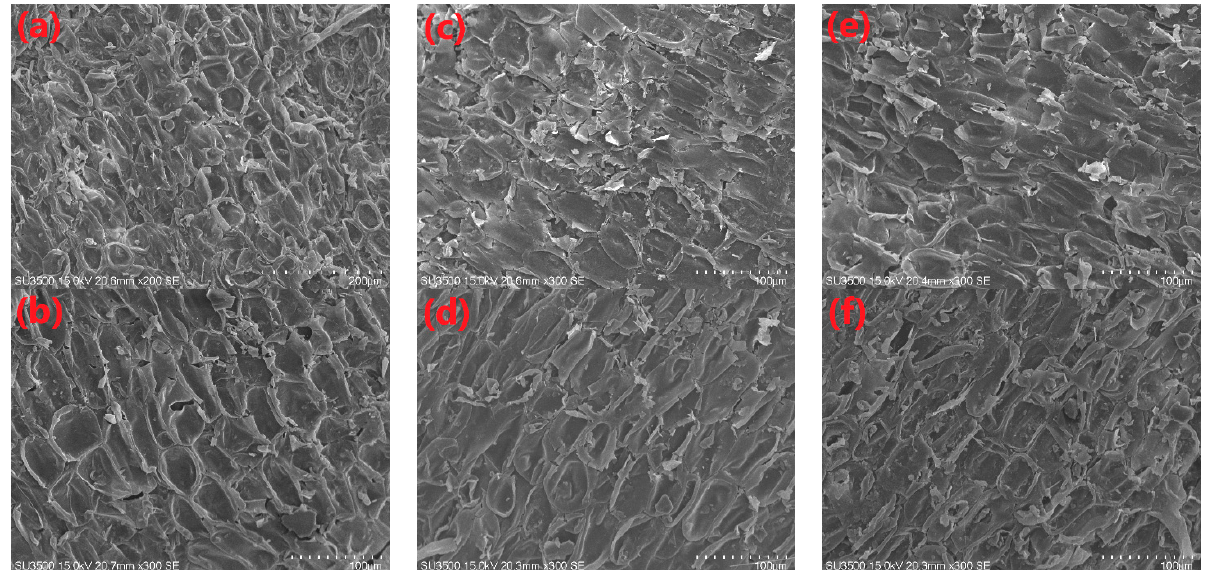
Figure 7. SEM micrographs of dried Ophiopogonis Radix . ( a ) Dried at 50 °C with 12 m/s, ( b ) dried at 60 °C with 12 m/s, ( c ) dried at 70 °C with 12 m/s, ( d ) dried at 60 °C with 6 m/s, ( e ) dried at 60 °C with 9 m/s, and ( f ) dried at 60 °C with 15 m/s.